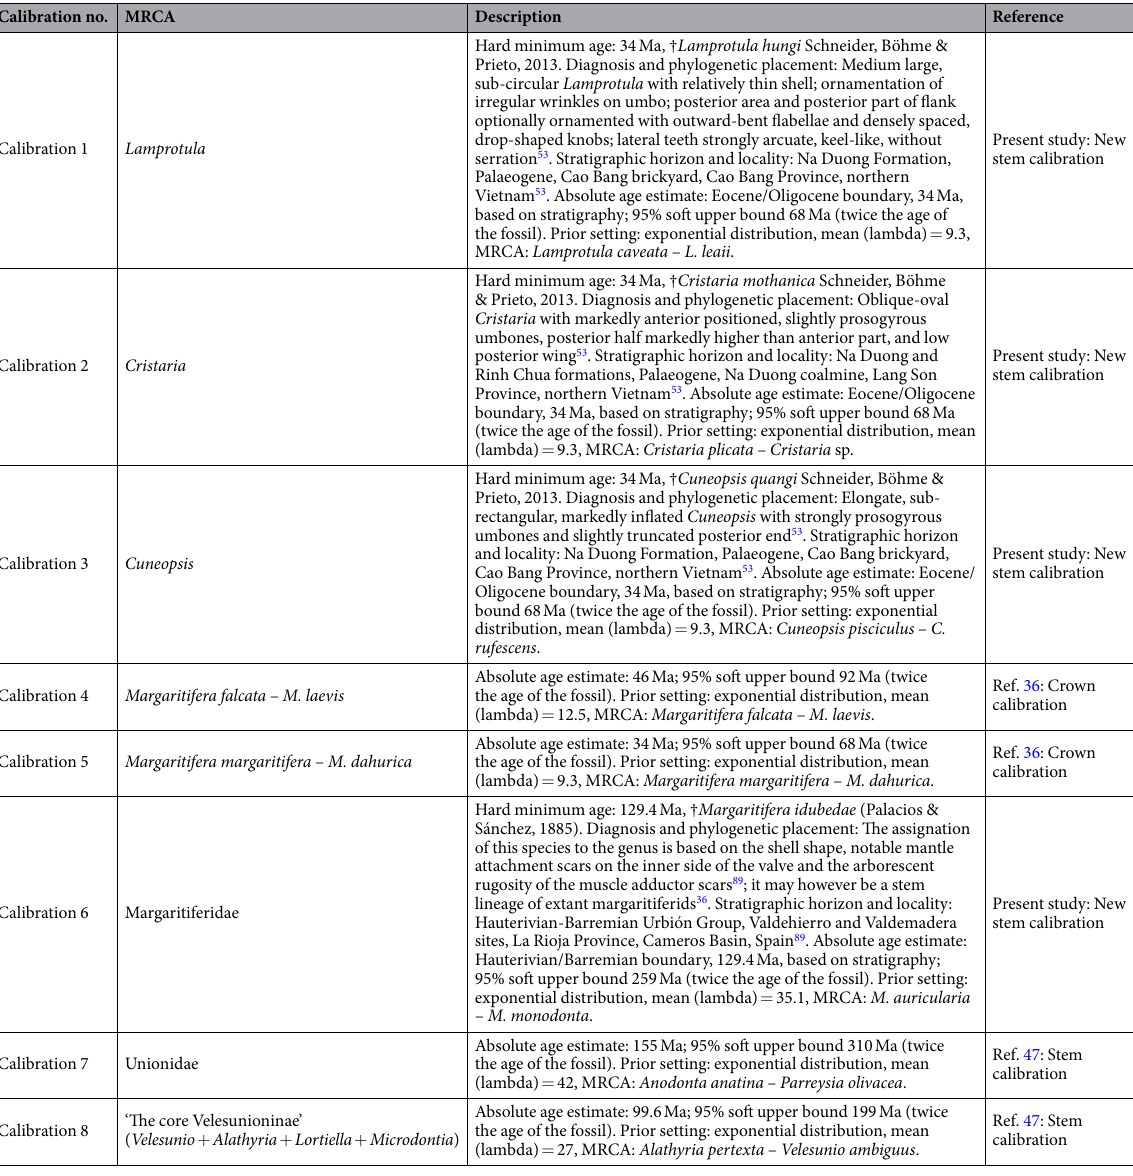
Table 1. List of fossil calibrations that were used in BEAST